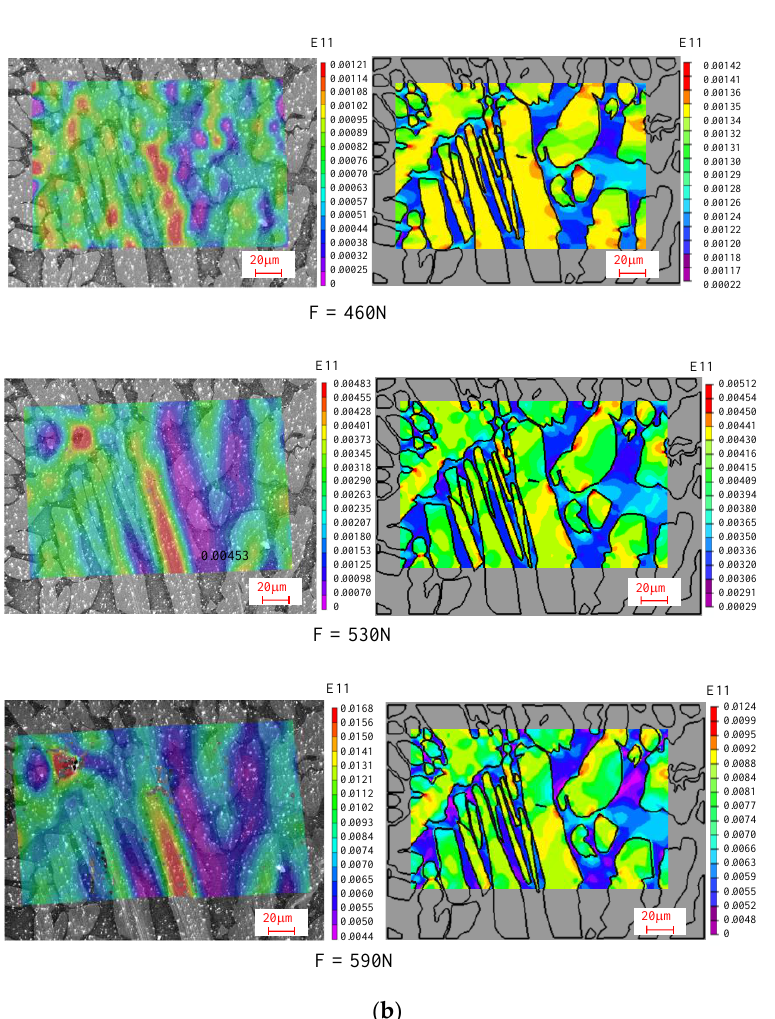
Figure 12. Comparison of the strain distribution contours of FEA results and experimental results under different loads: ( a ) 1# region, ( b ) 2# region.